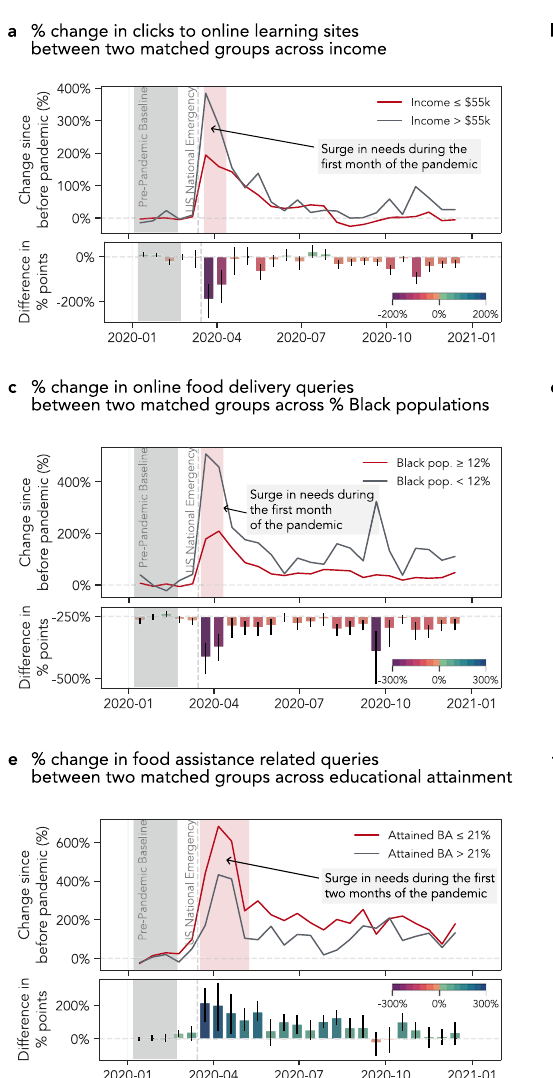
Fig.3|Disparitiesinshiftingtodigitalresources.a Onlinelearningsitesplayeda signi fi cant rolein fi lling in the gaps introducedby schoolclosures atthe beginning of the pandemic with anover200%increase inengagement. b However,ZIP codes with lower income and higher proportions of Black or Hispanic residents experi- enced smaller changes in queries that resulted in clicks to online learning sites duringthe fi rstmonth. c Withmandatedlockdowns,populationshavetransitioned tofooddeliveryservicesduringthepandemic,buttherateofchangeinonlinefood delivery queries is more than twice for ZIP codes with lower proportions of Black residents. d We see that ZIP codes with higher proportions of Black or Hispanic